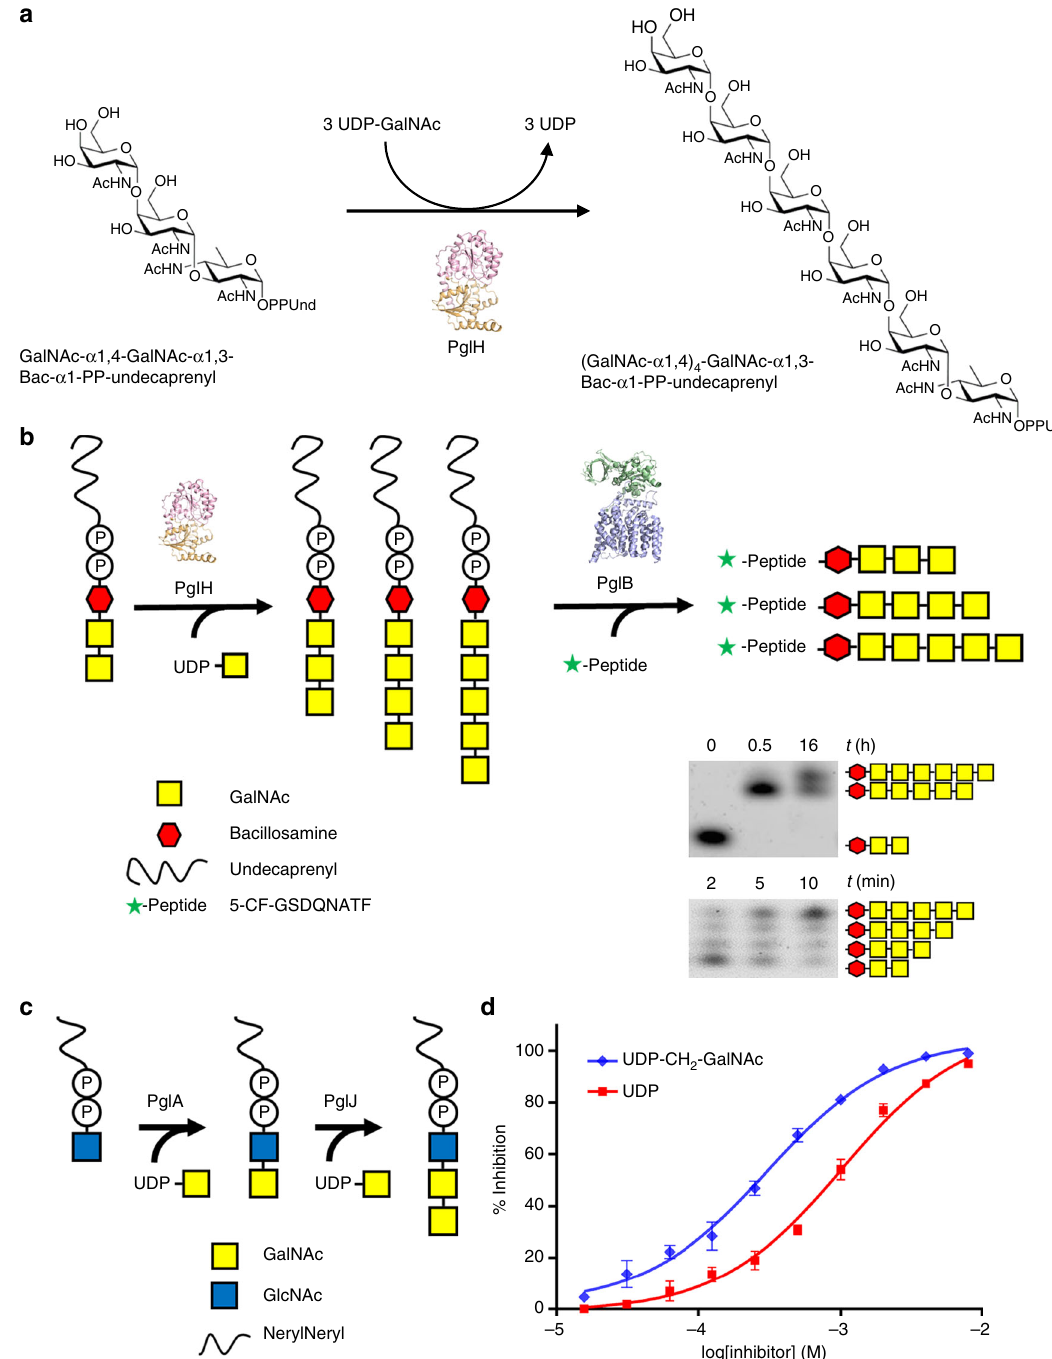
Fig. 1 In vitro activity. a Reaction catalyzed by PglH during bacterial LLO biosynthesis. b Schematic representation of the in vitro assay used to quantitate PglH activity, with symbol legend at the bottom left of the panel. In a fi rst step, tri-LLO is elongated by PglH. In a second step, the resulting glycan is transferred to a fl uorescently labeled acceptor peptide using puri fi ed PglB protein. Green stars represent carboxy fl uorescein attached to the N terminus of the synthetic peptide. c Schematic representation of the chemo-enzymatic generation GalNAc- α 1-4-GalNAc- α 1-4-GlcNAc- α 1-PP-NerylNeryl, using puri fi ed PglA and PglJ proteins, with symbol legend at the bottom left of the panel. d PglH activity was measured in the presence of different concentrations of reaction inhibitors UDP or UDP-CH 2 -GalNAc. Relative inhibition values were calculated, allowing IC 50 determination. Data points re fl ect the mean of three separate measurements, error bars indicate